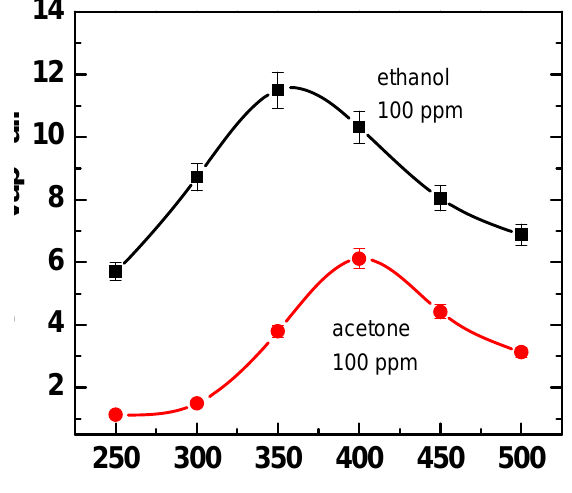
Figure 13. Response of the TiO working